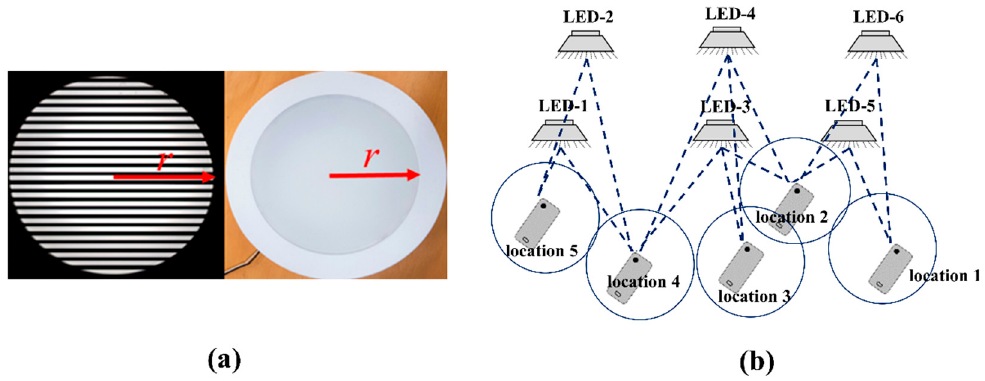
Figure 8. ( a ) Determination of area of the LED light; ( b ) location estimate and change of LEDs within FOV of camera from one location to another.